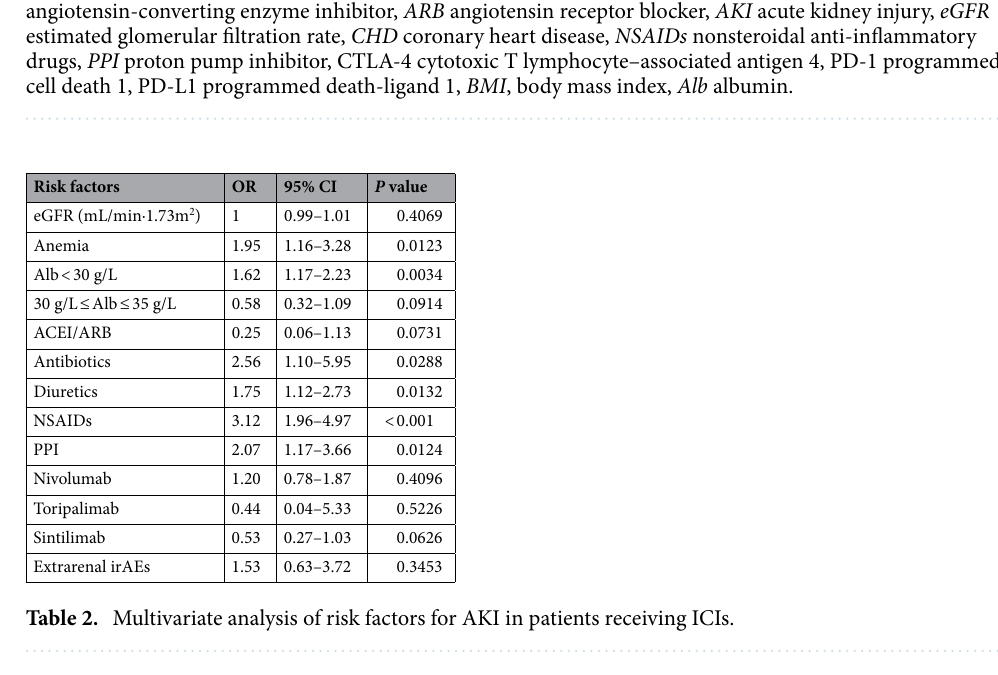
Table 1. Baseline characteristics and univariate analysis comparing AKI and non-AKI patients. ACEI angiotensin-converting enzyme inhibitor, ARB angiotensin receptor blocker, AKI acute kidney injury, eGFR